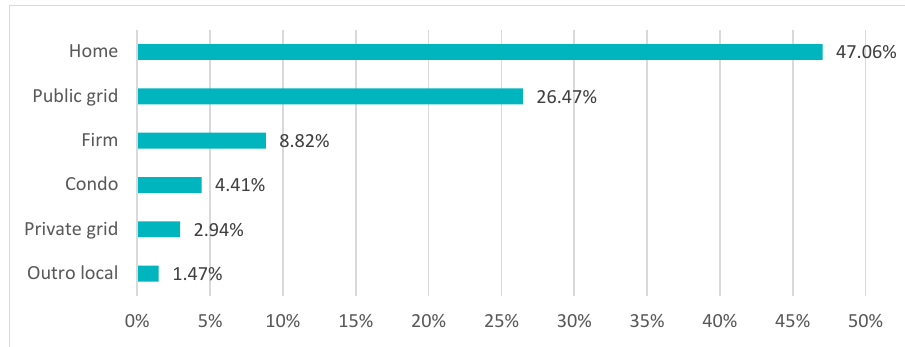
Figure 14. Preferred charging locations.